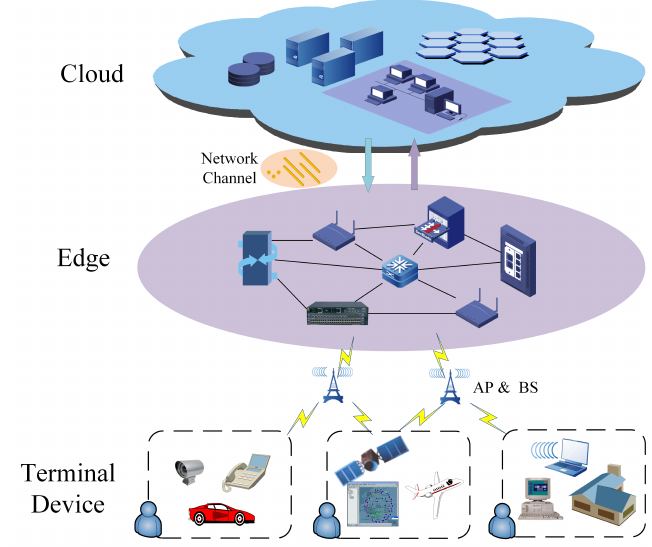
Figure 1. cloud-edge-end-collaborative computing offload system